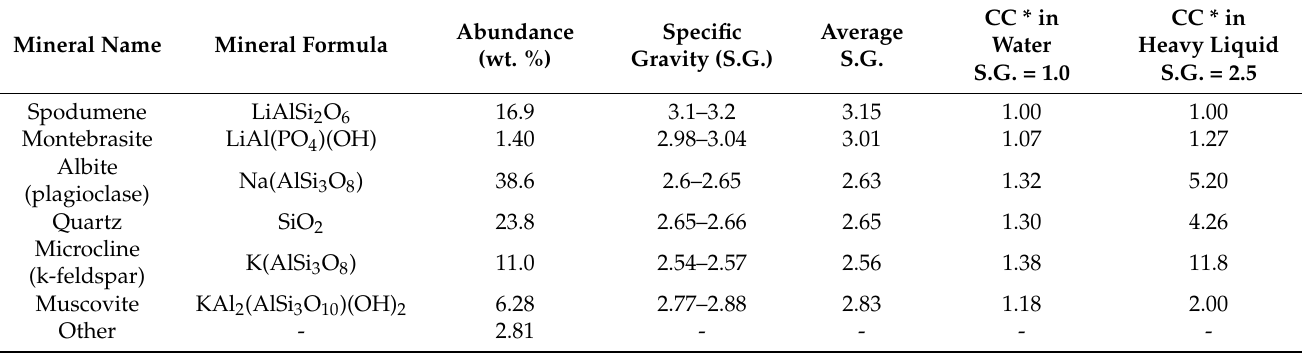
Table 4. Summary of mineral abundance in the composite head sample; specific gravity; and concentration criterion (CC) in water and heavy